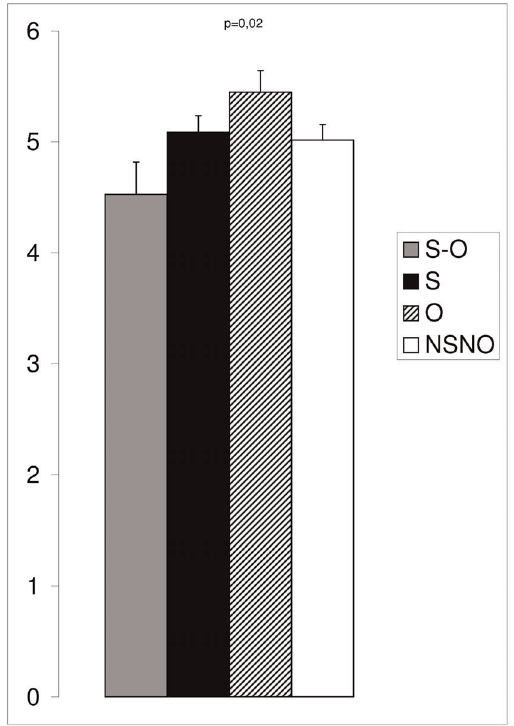
Figure 1. Mean dietary diversity score (DDS) for each group of children. S-O: stunted-overweight children (n=19), S: Stunted children (n=35), O: Overweight children (n=38), NSNO: Non-stunted-Non Overweight children (n=59). p-value corresponds to the analysis of variance between the four groups. Error bars represent standard error of the mean. S-O children have a significantly less diversified diet than O children (p=0.01, post hoc pair-wise comparison).